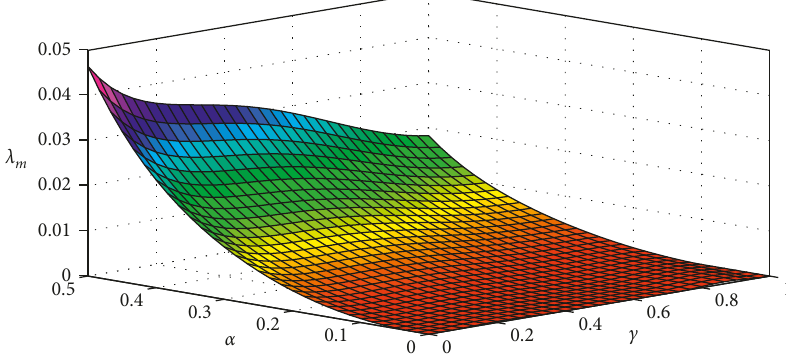
Figure 7: λ m values in function of α and